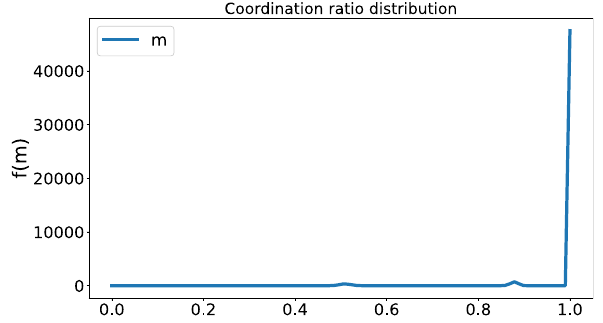
Figure 10. Coordination ratio (left) and aspiration (right) distributions. A 0 = 0.8 and h = 10 − 3 .